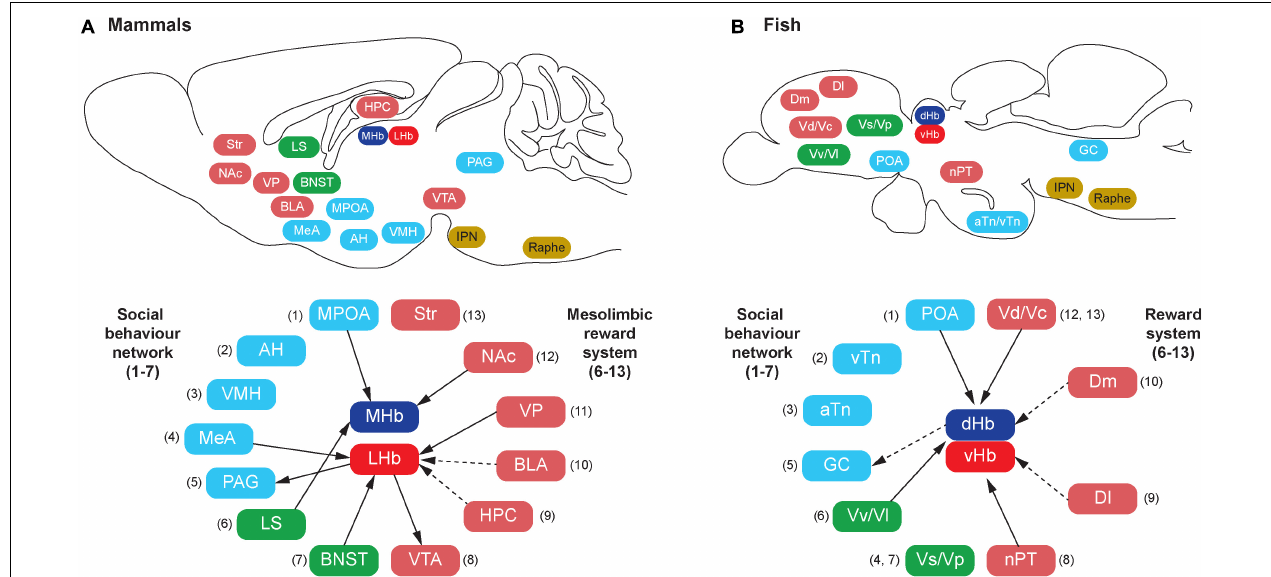
FIGURE 1 | Schematic illustration of habenula connectivity with the social decision-making network (SDMN) in vertebrates. In mammals (A) , the SDMN comprises the social behavior network (SBN) (1–7) and the mesolimbic reward structures (6–13), but some structures are shared by the SBN and the mesolimbic reward structures (6 and 7). In teleosts (B) , each brain region that has been suggested to be homologous to the respective components of the mammalian SDMN is indicated by the corresponding number (shown in parentheses). In mammals, the habenula consists of the medial (MHb) and lateral (LHb) subnuclei, which receive direct (solid lines) or indirect (dotted lines) projection from the component of SDMN. In teleosts, the habenula consists of the dorsal (dHb) and ventral (vHb) subnuclei, which are homologous to mammalian MHb and LHb, respectively. Similar to mammals, there is connectivity between the habenula and teleostean SDMN. However, the detailed subnuclei-specific connectivity has not been precisely characterized in fish brain. The abbreviation of brain regions refers to Table 1 . TABLE 1 | Summary of proposed homologies of between brain nuclei/regions in social decision-making network of mammals (rodents) and teleosts. Classification of